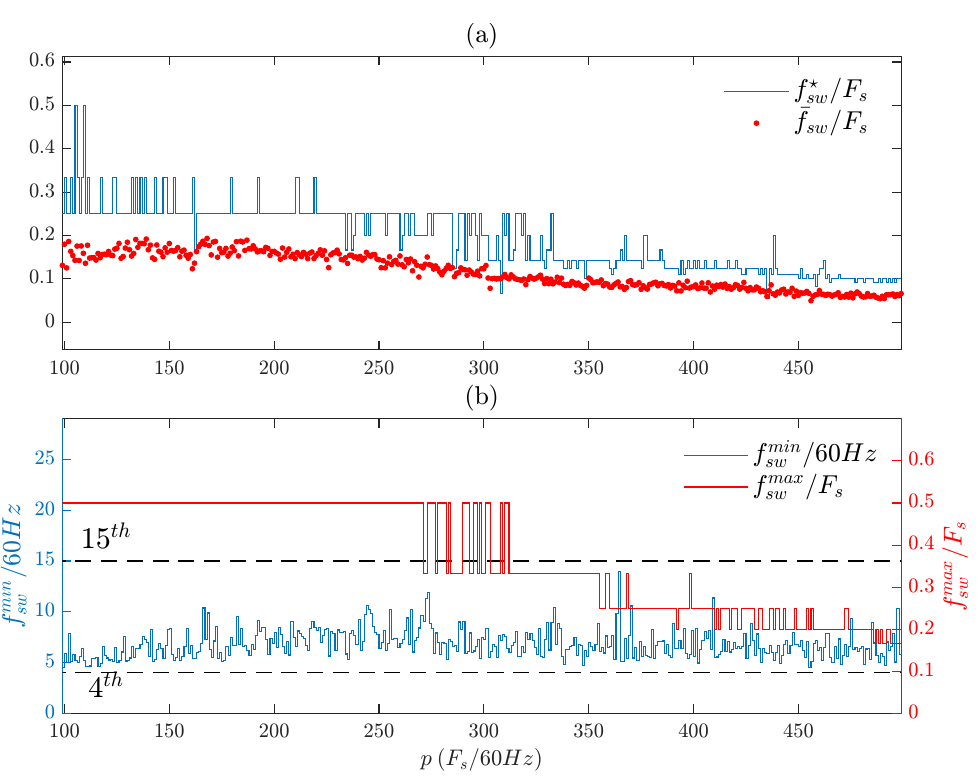
Figure 14. Sampling frequency effect in FCS-MPC using the cost function (11) ( λ = 0.005): ( a ) f (cid:63) sw and ¯ f sw ; ( b ) f max sw and f min sw .